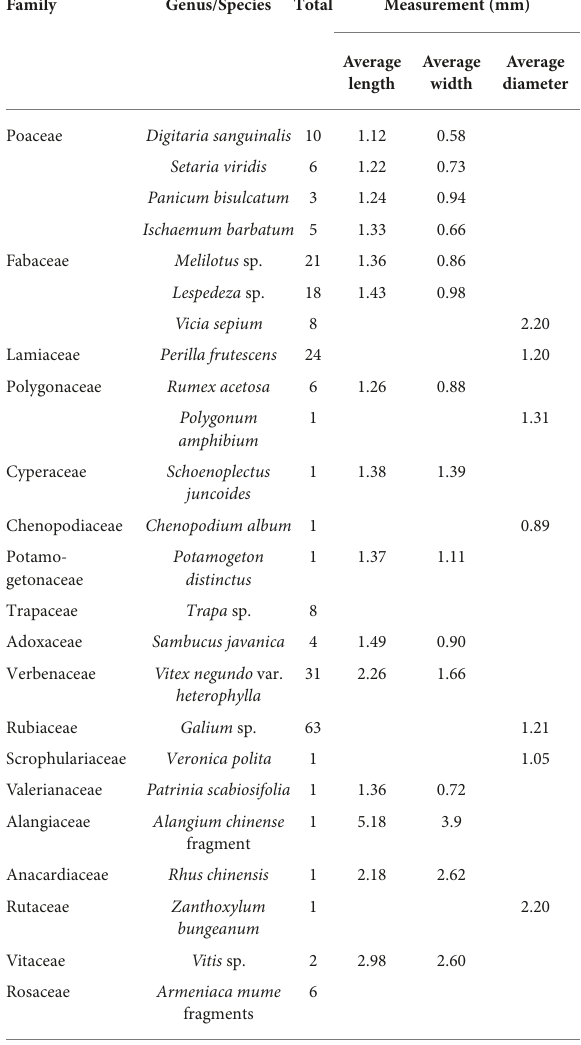
TABLE 3 The quantity and measurement for non-crops at Wanfunao. Family